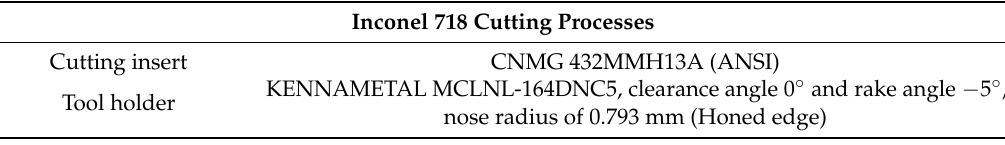
Table 1. The cutting tool information during machining of Inconel 718.